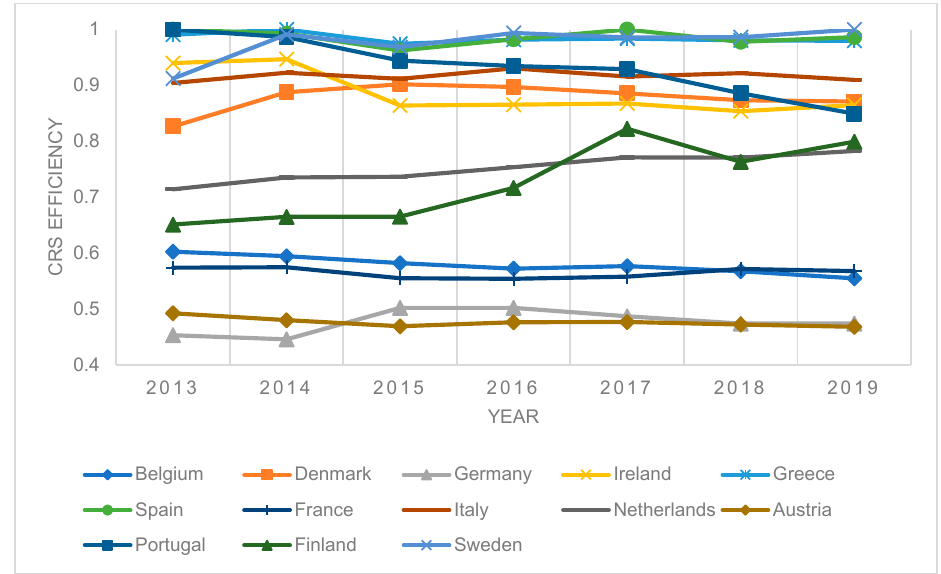
Figure 1. Results of DEA window efficiency measurement—CRS model, selected countries.